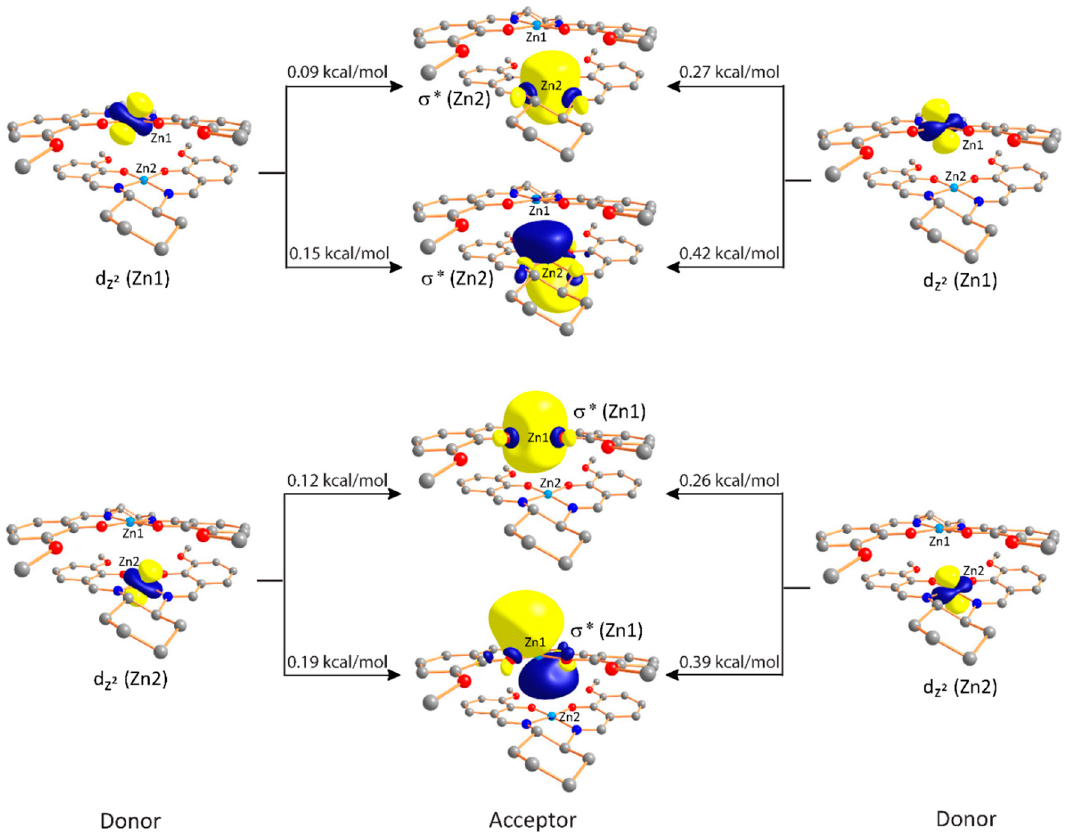
Figure 5. LP → LP* donor–acceptor orbitals interaction derived from NBO analysis of [Zn(sal)](H 2 O) (dimeric form). Hydrogen atoms are omitted for clarity (isovalue = 0.03).